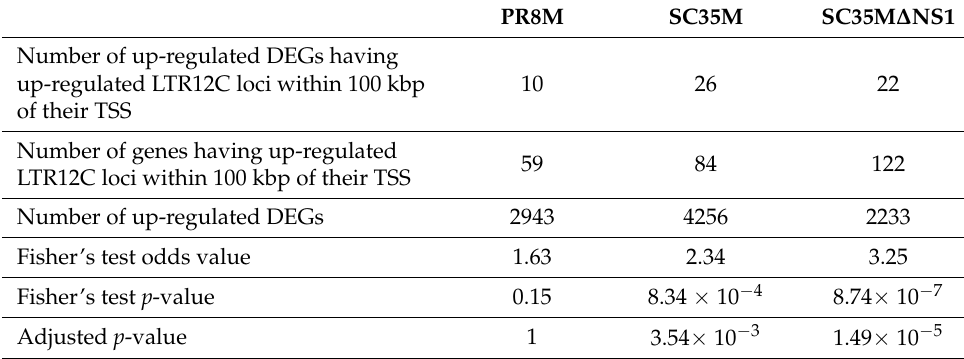
Table 2. Data on LTR12C occurrence used in the Fisher’s test. The total number of genes considered in this test is 26423. See Methods for details on Fisher’s test model.